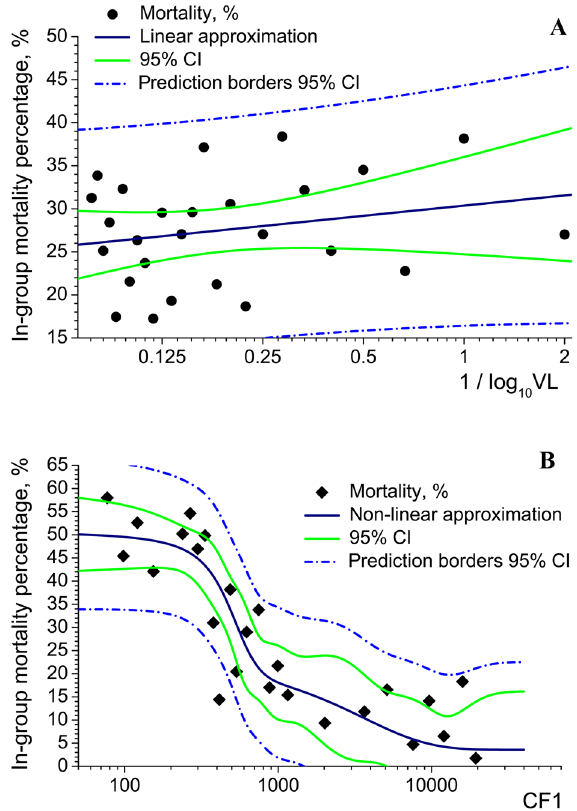
Figure 7. Dependence of in-group mortality percentage on VL ( A ) and CF1 ( B ), experimental data and approximation. For detailed description please see the text. Created in OriginPro ver. 9.2.196, https:// www. origi nlab.